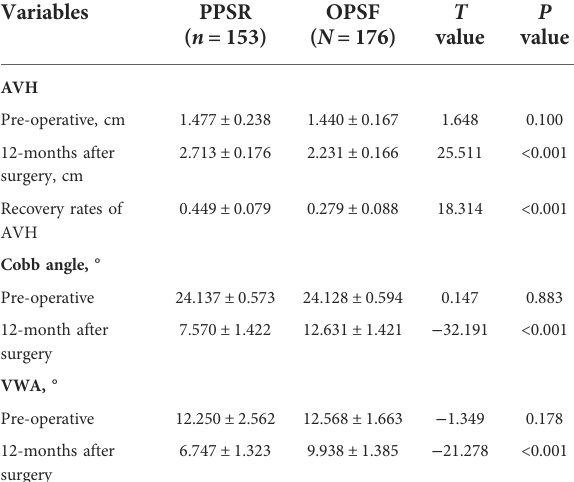
TABLE 3 Preoperative and postoperative AVH, cobb angle, and VWA in PPSR and OPSF groups.